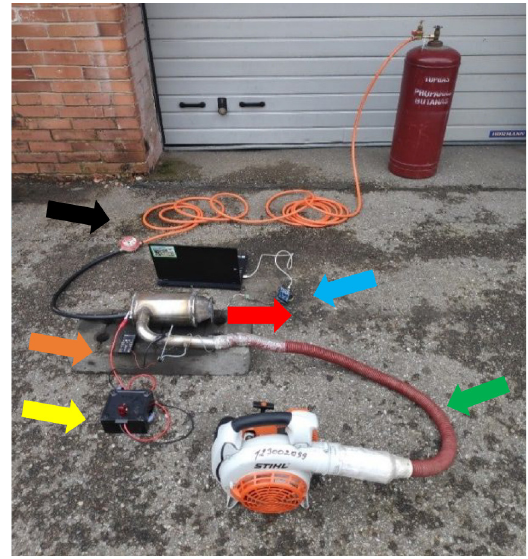
Figure 3. Black arrow – gas supply pipe with a flow meter, orange arrow – differential air pressure sensor, yellow arrow – ignition module, green arrow – air pipe with compressor, blue arrow – exhaust gas temperature module, red arrow – exhaust gas flow